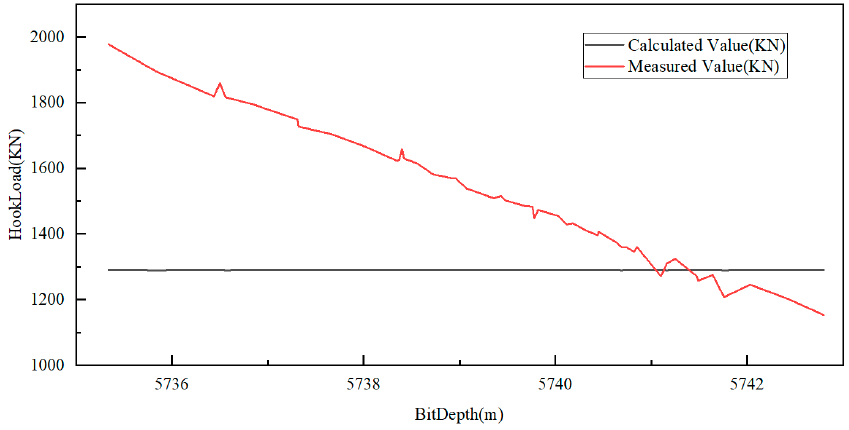
Figure 5. Distribution of measured and calculated POOH hookload while sticking.